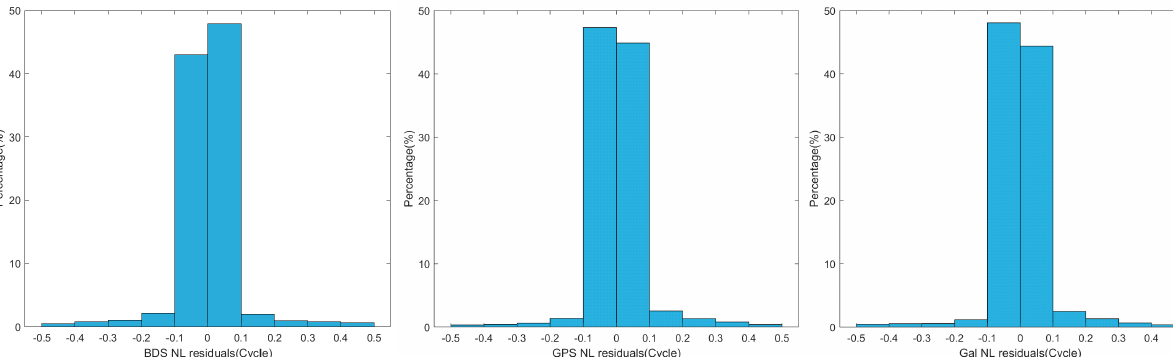
Figure 6. The WL residual distributions of the BDS-3, GPS, and Galileo on DOY 301, 2021.